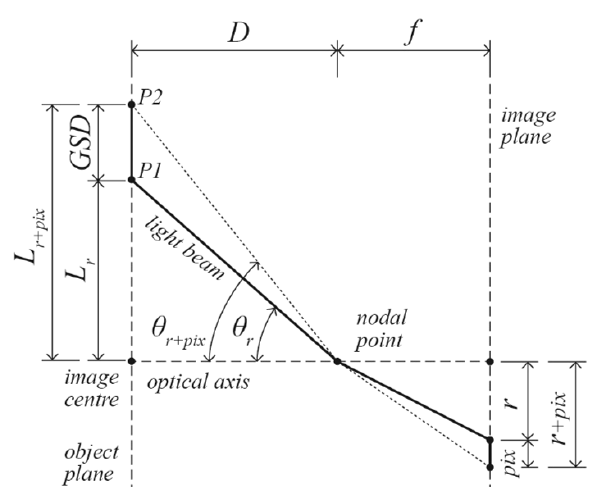
Figure 2. Illustration of the relation between pixel size and GSD for each projection